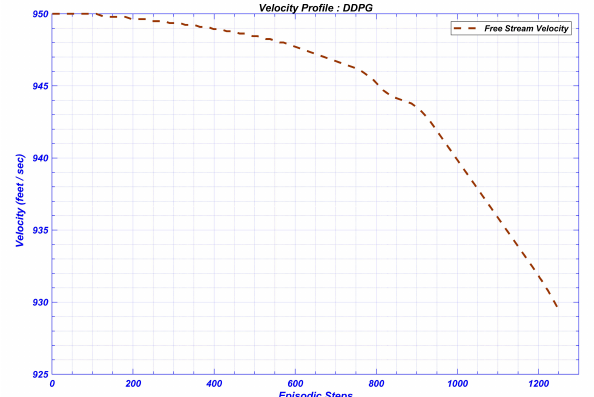
Figure 6. UAV Velocity profile.